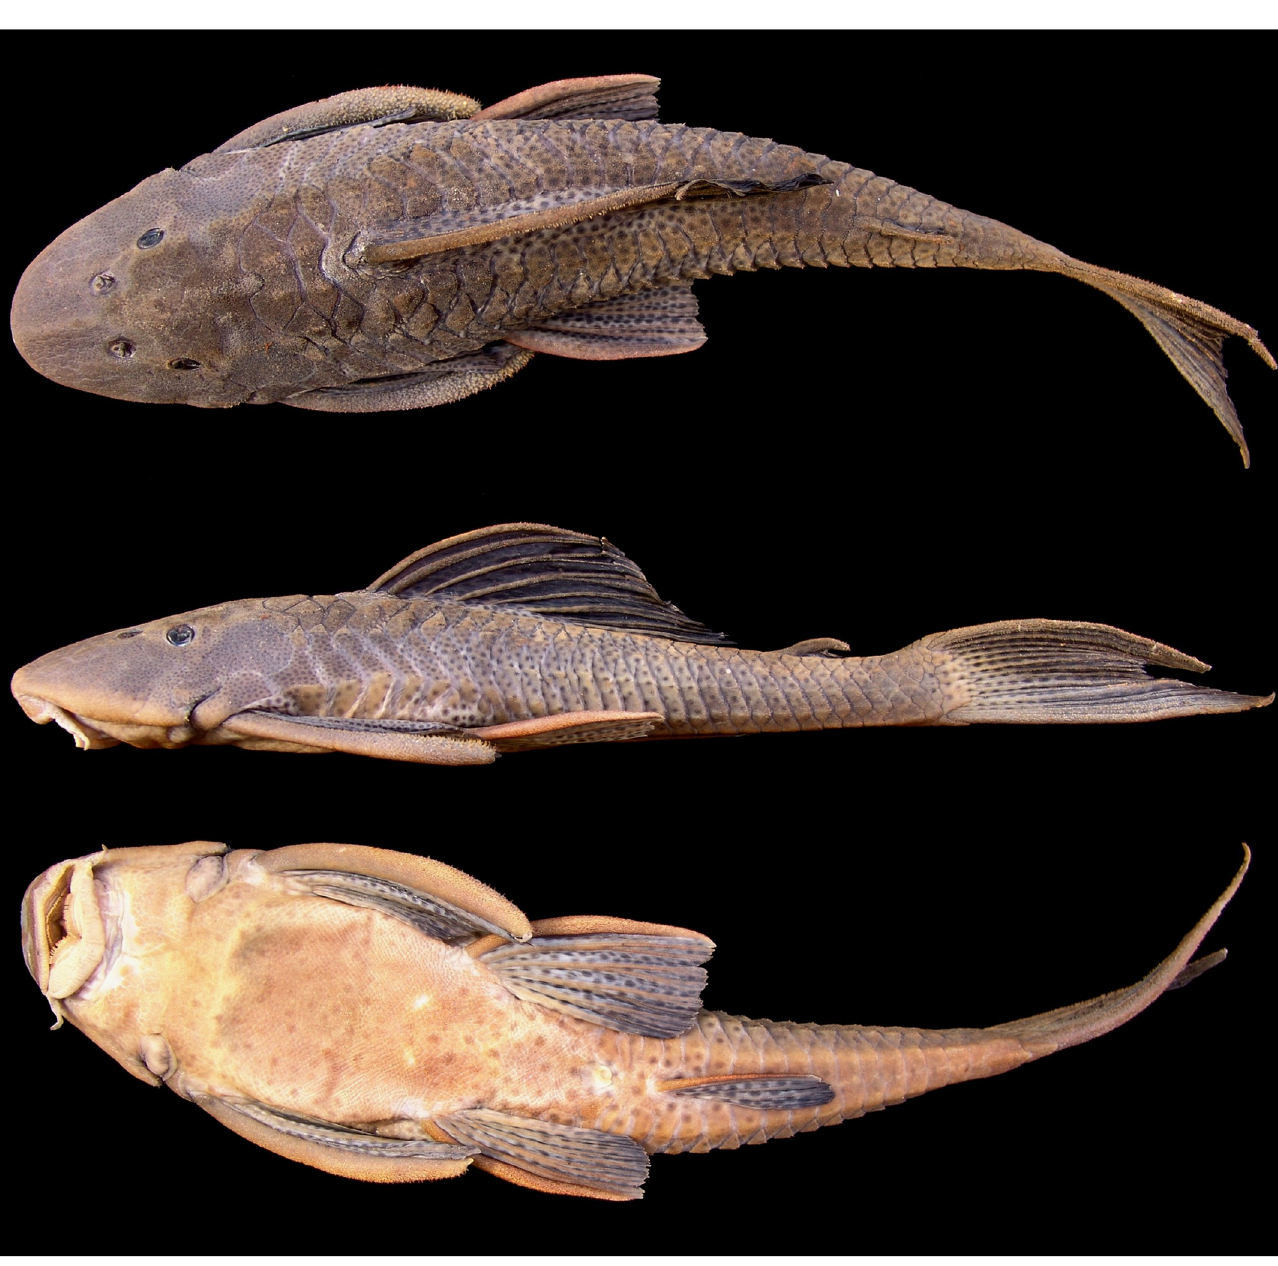
Body covered with five rows of dermal plates with moderately-developed odontodes, except on base of dorsal fin and small naked area on snout tip. Predorsal region with very slight median keel. Dorsal, mid-dorsal, mid-ventral, and ventral series of plates with moderate keels. Median series with weakly developed keels; bearing uninterrupted lateral line. Ventral series bent ventrally. Ventral surface of head covered with platelets, except for region behind lower lip. Abdomen covered with minute platelets in specimens larger than 110 mm SL, with